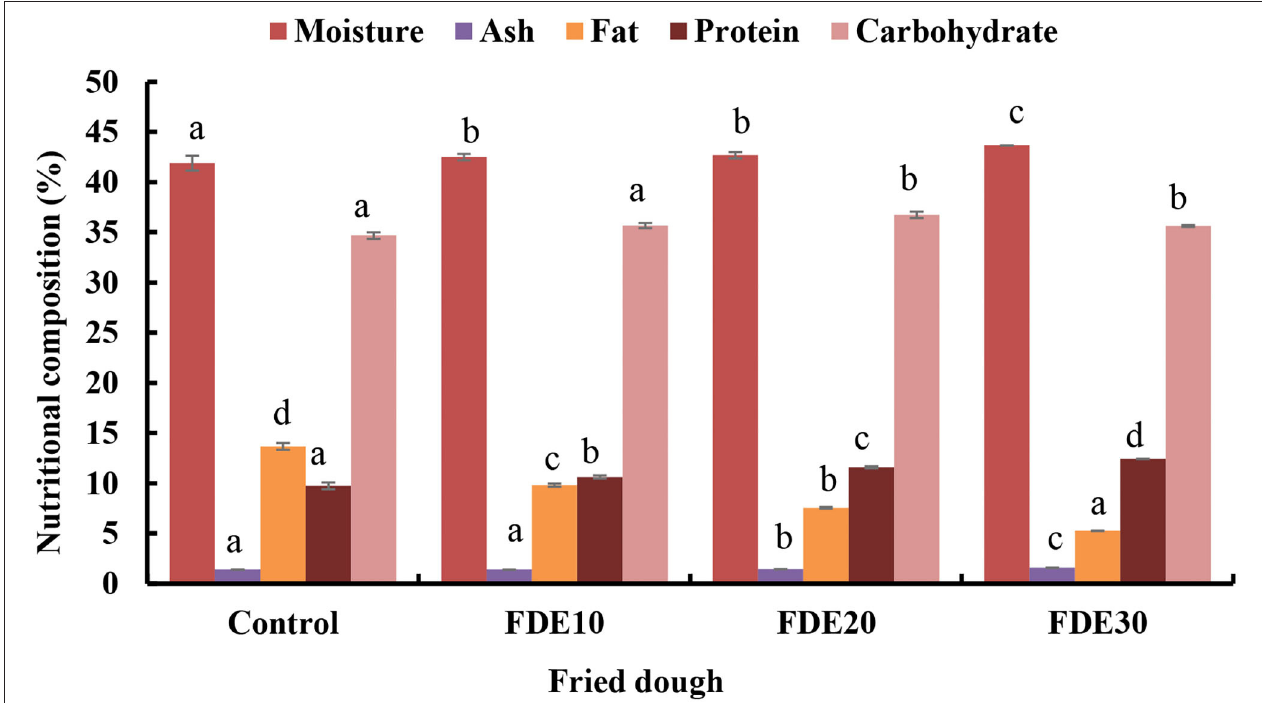
FIGURE 3 | Nutritional composition of egg-enriched fried dough. Results were presented as mean ± standard deviation ( n = 3). Superscripts were assigned to show significant differences ( p < 0.05) with an increase in egg in similar bars using Duncan multiple range test. FDE = egg-enriched fried